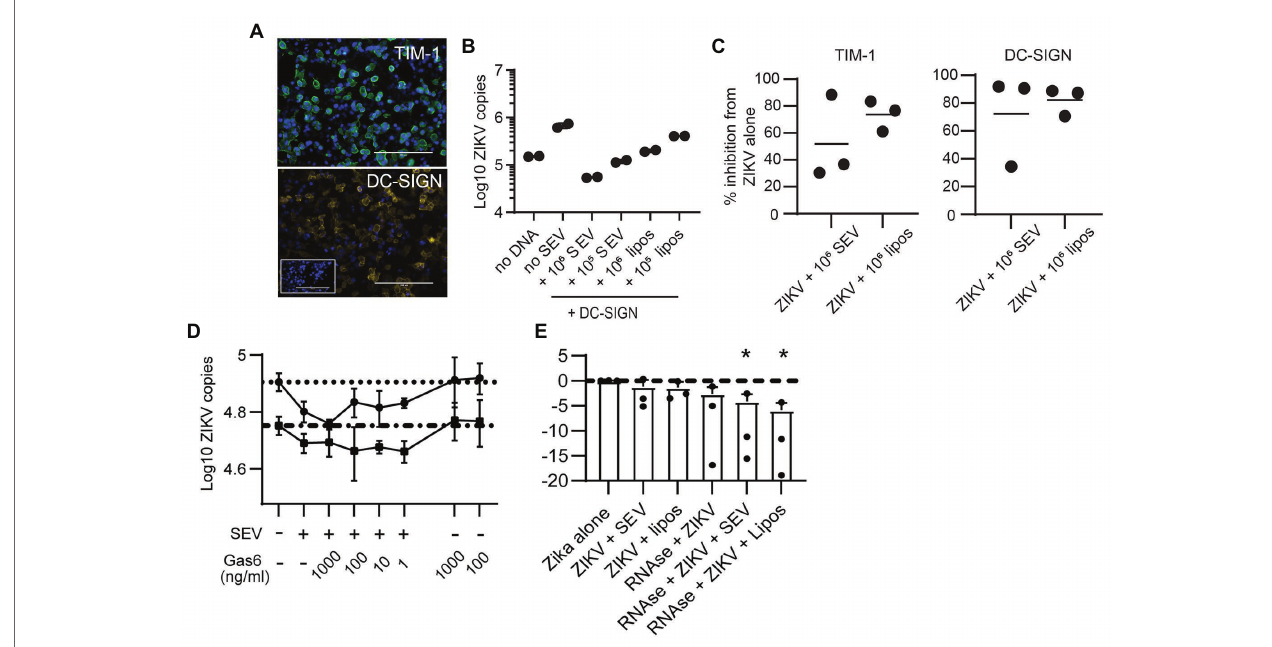
FIGURE 5 | Seminal extracellular vesicles and liposomes inhibit ZIKV by causing loss of virion membrane integrity. (A) HEK293 cells were transfected to express the DC-SIGN or TIM-1 receptors. Twenty-four hours post transfection, cells were stained with antibodies against TIM-1 (top panel, green) or DC-SIGN (bottom panel, yellow) to visualize expression of receptors. DAPI staining visualizes the cell nucleus (blue). Mock-transfected cells incubated with anti-DC-SIGN are shown in the inset for the DC-SIGN panel. Scale bar is 200 μ m for all images (imaged at 20x magnification). (B) ZIKV was incubated alone or with 10 6 SEV or liposomes per PFU for 1 h prior to infecting DC-SIGN transfected cells at an MOI of 1 for 1.5 h. Inoculum was removed and cells were cultured for 24 h, then cultures were lysed. Log copies of ZIKV RNA quantified by ddPCR and normalized to the housekeeper gene RPP30 are plotted. Each symbol is from one well. Plot is a representative result from two separate experiments. (C) HEK-293 cells transfected to express DC-SIGN or TIM-1 were infected as in B, and the percent inhibition from the ZIKV alone condition is plotted. Each symbol is the average of two duplicate wells from two separate experiments and the line indicates the mean (D) ZIKV was incubated alone or with 10 5 SEV per PFU for 1 h, prior to infecting cells. During incubation with viral inoculum, recombinant Gas6 protein was added to the culture at the indicated concentrations. After 1.5 h, viral inoculum was removed and cells were lysed to quantify ZIKV genomes with ddPCR. Each line represents the average of two technical replicates from two different epithelial cell lines, done in separate experiments. Dotted lines show the copy numbers obtained in the ZIKV alone condition for each cell line. (E) ZIKV virions were incubated alone or with 10 6 SEV or liposomes for 1 h at 37 ° . One microliter of an RNAse A/T1 cocktail was added for 20 min at 37 ° , and then samples were lysed for total RNA extraction. ZIKV genomes were quantified with qPCR. Log10 copies of ZIKV virus genome normalized to the virus alone condition are plotted; the line indicates ZIKV alone. Results from three independent experiments are shown as dots; bars are mean and lines are standard deviation. * p < 0.007 by one-way ANOVA with Tukey’s multiple comparisons